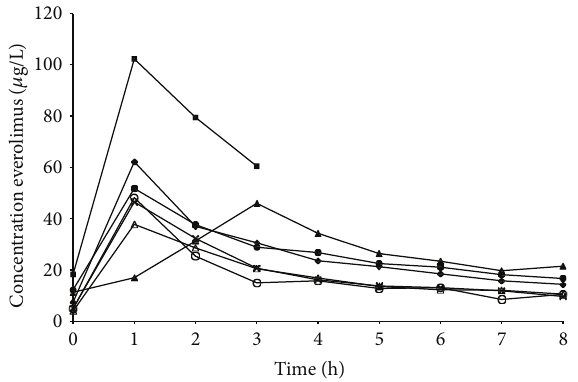
Figure 3: Individual observed concentration versus time profiles for everolimus.